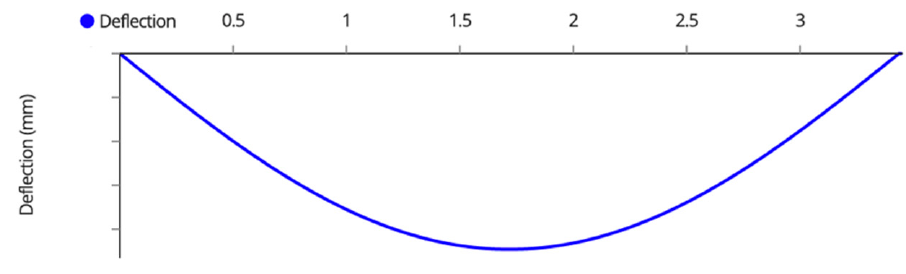
Figure A4. The 2 × 4 Wind Load Deflection Diagram. The maximum deflection occurs at midspan and can be calculated using Equation (A6).